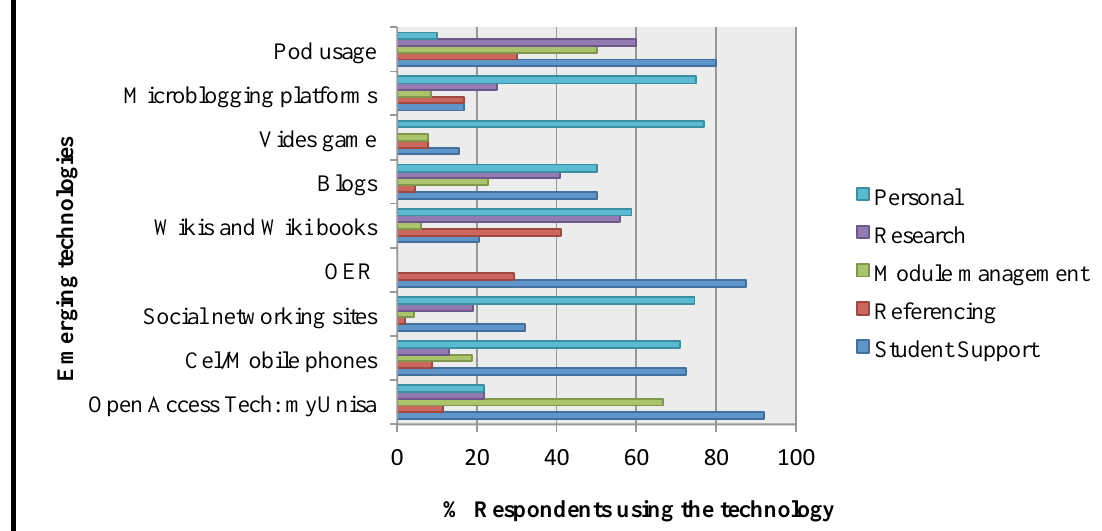
Figure 5a: Use of technology